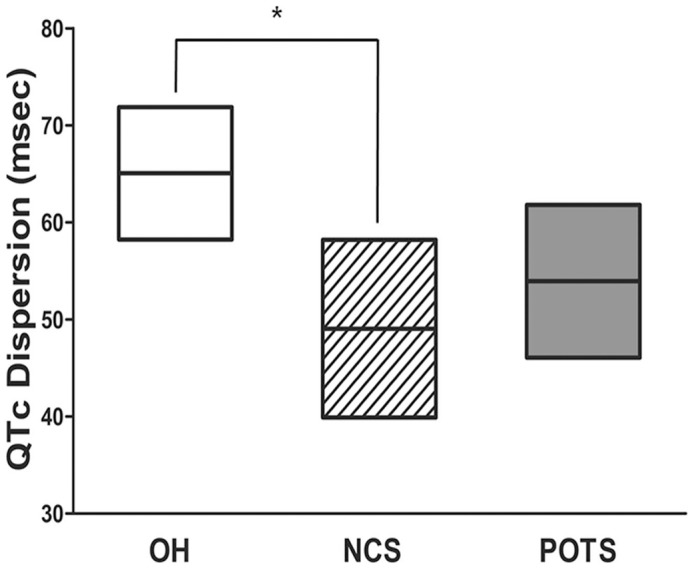
QTc dispersion results.Comparisons of the QTc dispersion showed significant differences between groups (p = 0.021). Post-hoc analysis revealed that patients with orthostatic hypotension (OH) had more increased QTc dispersion than patients with neurocardiogenic syncope (NCS) (uncorrected p = 0.037, age and gender-corrected p = 0.013). The top and bottom borders of the boxes represent the upper and lower limits of the 95% CI range, respectively. The horizontal lines in the middle represent the mean value. Asterisk (*) indicates significant results after correction for post-hoc comparisons.